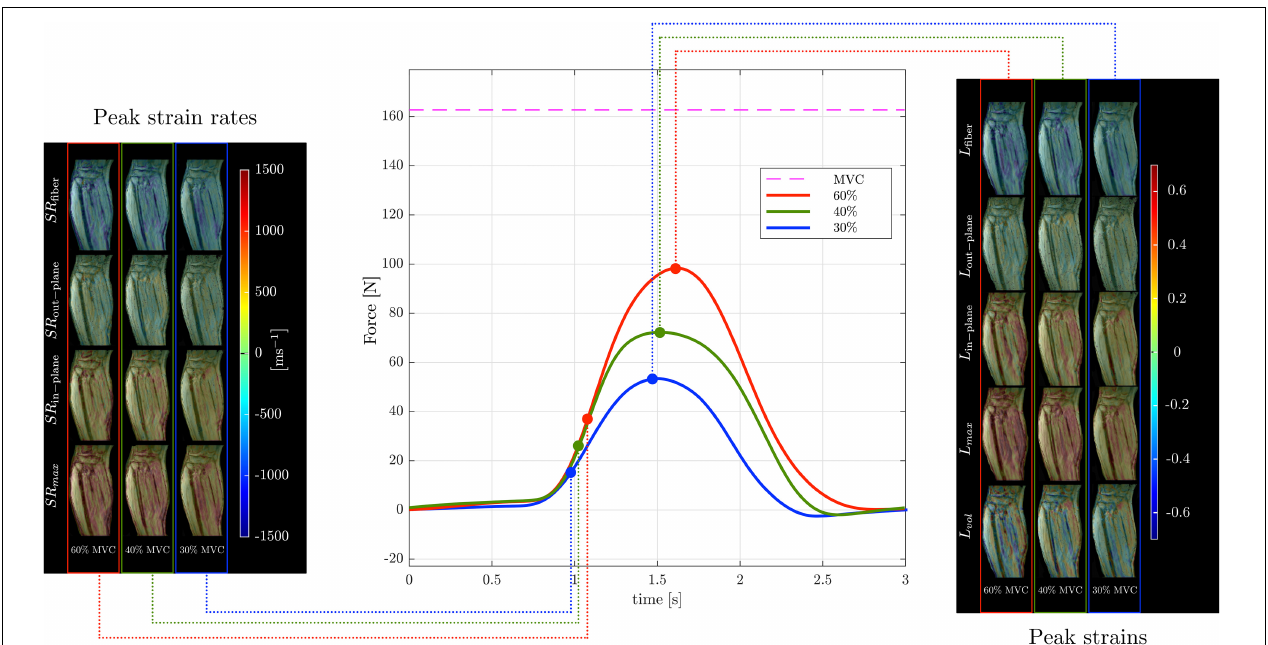
FIGURE 3 | Temporal variation of forces exerted by a young subject averaged during the MR data acquisition for different force levels (center panel) along with corresponding strain (right panel) and strain rate (left panel) colormaps at the peak values (of L fiber or SR fiber ) during the contraction phase of the dynamic cycle for 60% (left column), 40% (middle column), and 30% MVC (right column). The colormap bars are shown in each panel. The temporal frames at which the peaks during contraction occurred for strain and strain rate are marked on the force curves. While the peak in strains occur at the maximum force reached, peak in strain rates occur earlier and roughly correspond to the maximum slope of the force-time curve in the contraction cycle. The subscripts, fiber , out - plane , in - plane and max , vol for SR and L are explained in the text. Colormaps of the strain and strain rate indices for the entire MR acquisition cycle are presented in the Supplementary Figure S3